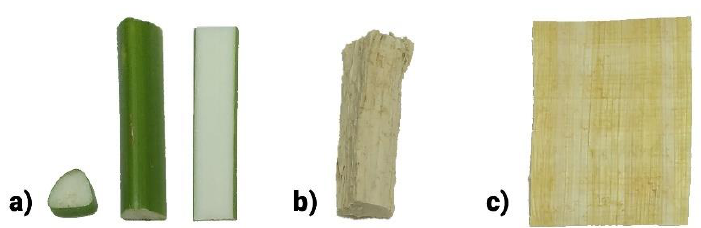
Figure 1. ( a ) Freshly cut papyrus stems in cross-section, part of a stem, and the stem cut in a longitudinal direction, as it is done for papyrus sheet production. ( b ) Dried papyrus pith, after the removal of the green rind. ( c ) A commercial papyrus sheet.